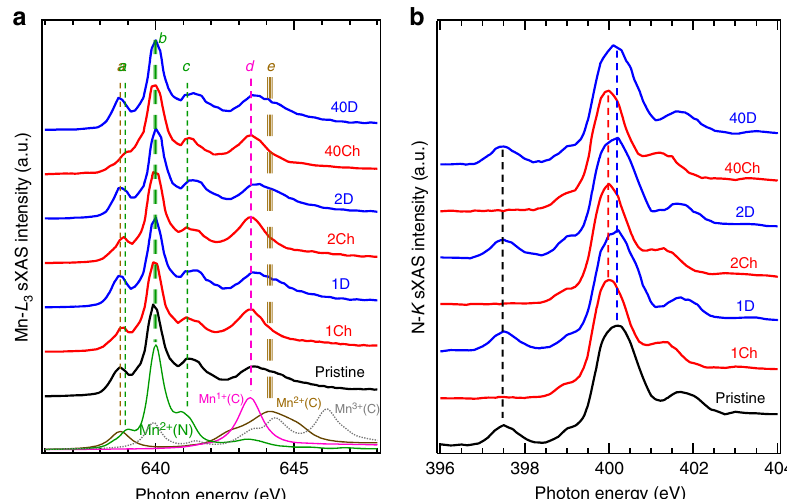
Fig. 3 sXAS probe of the Mn 1 + /Mn 2 + and the strong hybridization in MnHCMn electrodes. a Mn L 3 -edge sXAS spectra collected on a series of MnHCMn electrodes at the charged (reduced), marked with “ Ch ” , and discharged (oxidized), marked with “ D ” , states of the fi rst, second, and fortieth cycles. Calculated spectra of Mn II (N), Mn III (C), Mn II (C), and Mn I (C) are plotted at the bottom. The sXAS features are assigned to Mn with different oxidation states at different coordination sites (dashed lines). b The N K -edge sXAS spectra collected on the same series of MnHCMn electrodes. The red and blue dashed lines indicate the chemical potential shifts between the charged and discharged electrodes. The black dashed line indicates an unoccupied low- energy electron states from the hybridization of the NC ligands and Mn-3 d states at the discharged (oxidized) states. This hybridization state disappears due to the electron fi lling during the electrochemical charging (reducing)